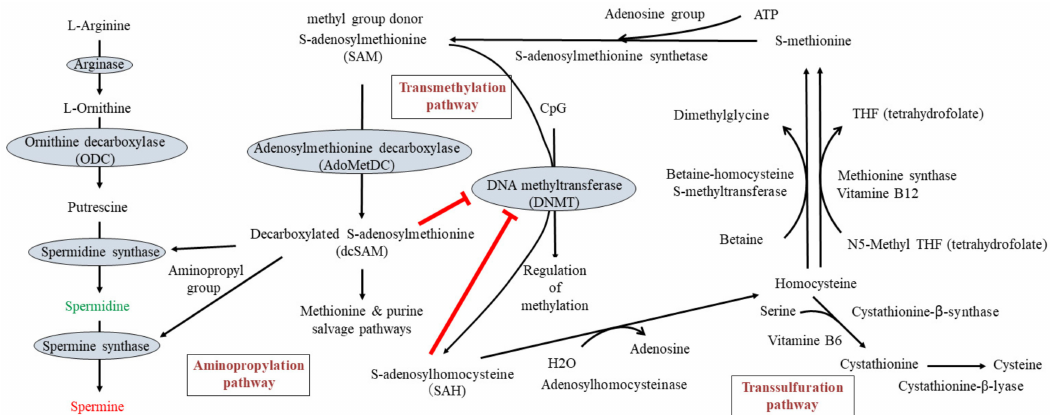
Figure 2. Polyamine metabolism (left), DNA methylation (middle), and one-carbon metabolism (right). T-bar indicates the inhibitory activity. Arrow indicates the metabolic pathway or flow of